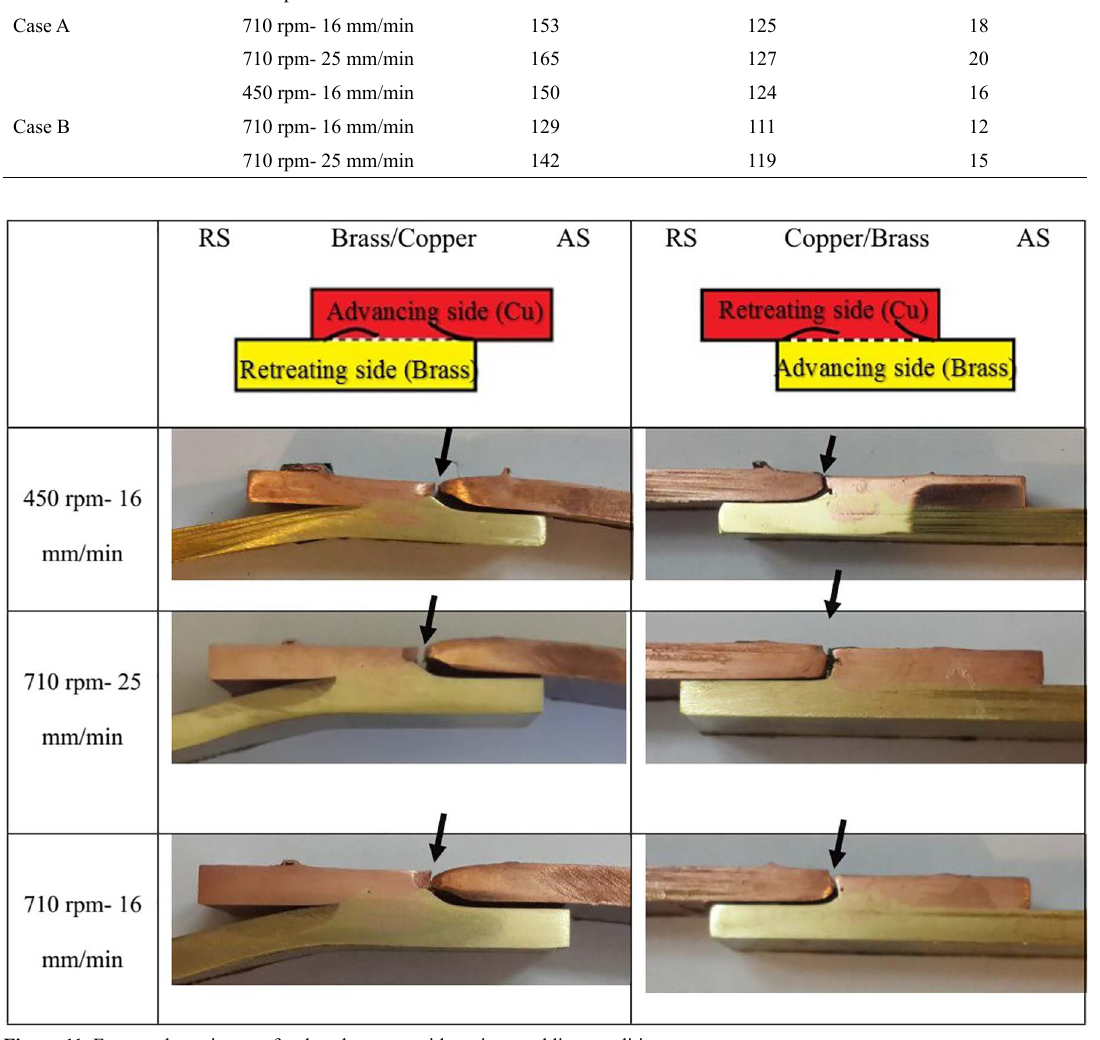
Figure 11. Fractured specimens after lap shear test with various welding